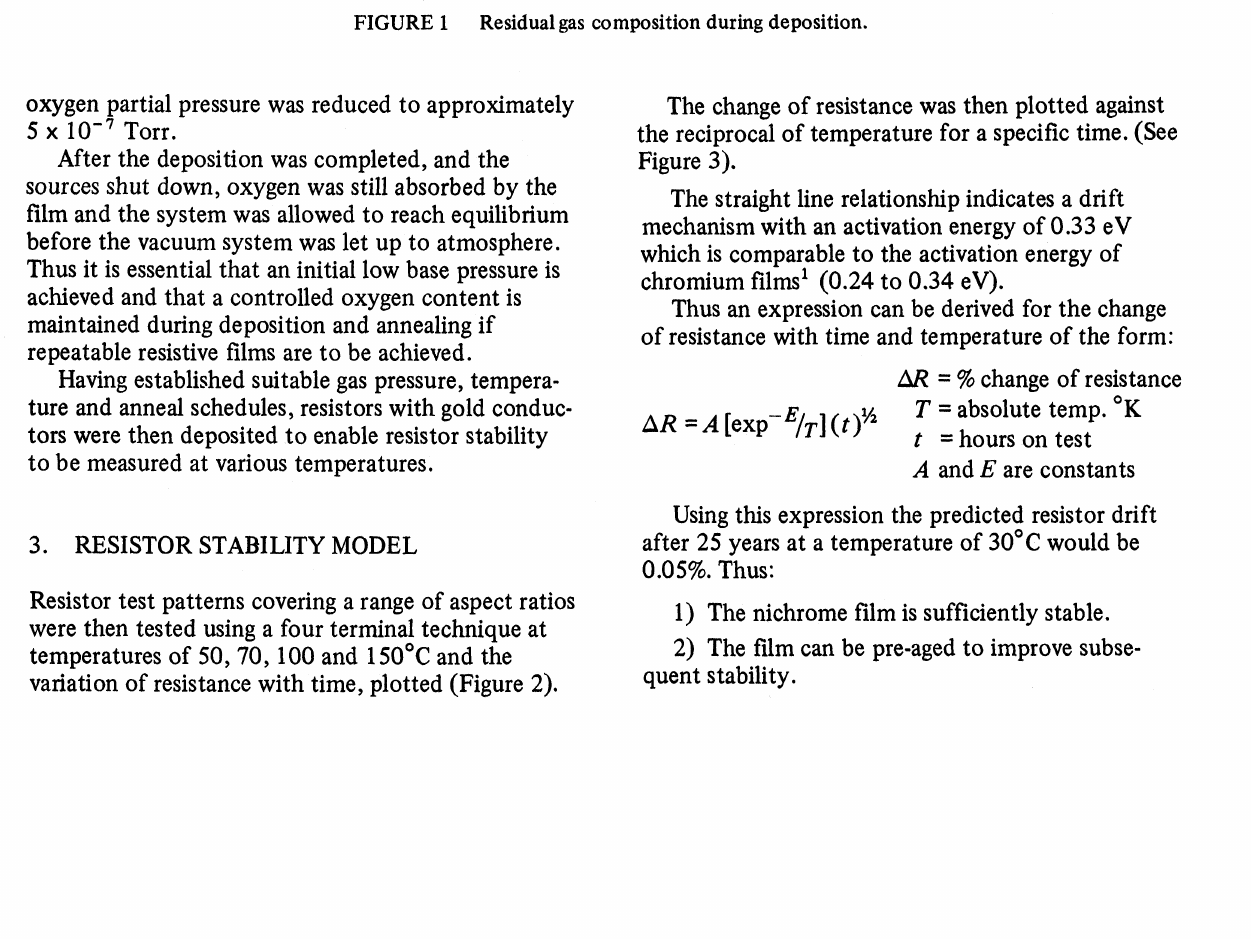
FIGURE Residual gas composition during